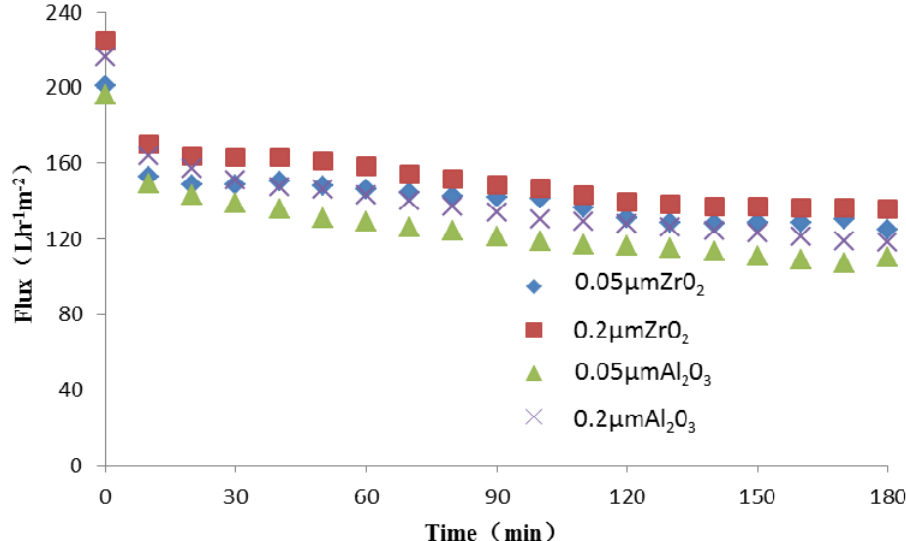
Figure 1. Influence of membrane on Tongbi liquor permeate